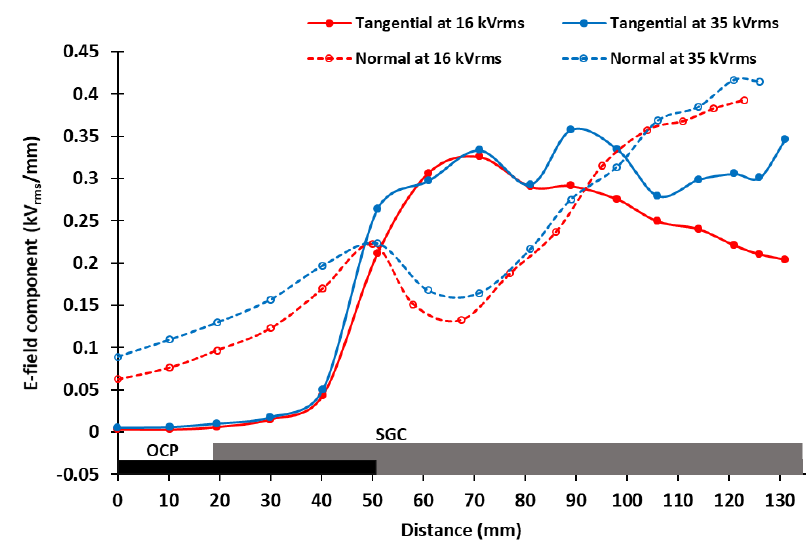
Figure 13. Comparison of E n and E t obtained at the central line on the surface of the stress grading system for an applied voltage of 35 kV rms .